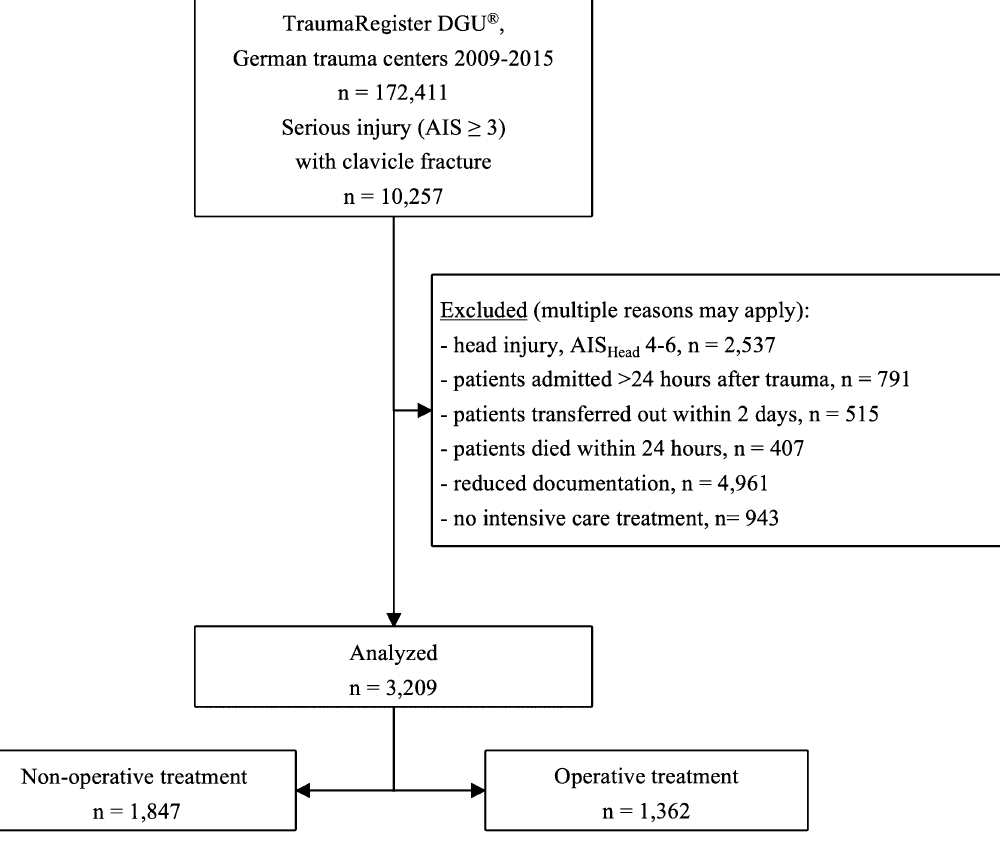
Figure 1. Flowchart showing inclusion and exclusion of patients for this